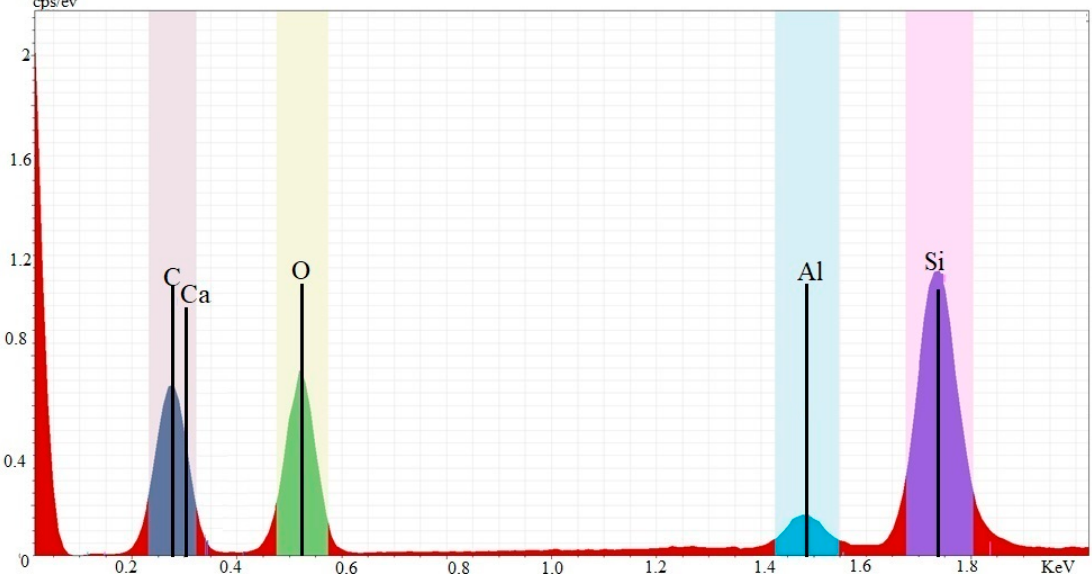
Figure 3. Energy-dispersive spectroscopy (EDS) element map of the as-received sample.